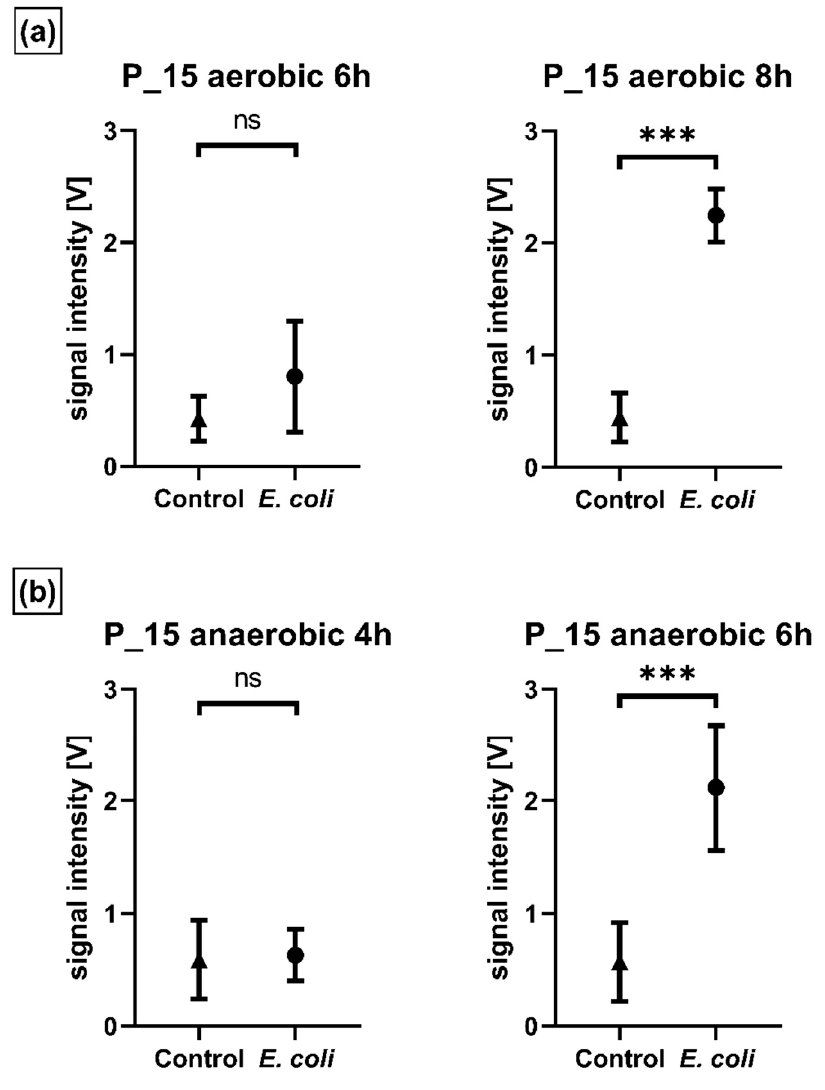
Figure 4. Unpaired t-Test E. coli ( n = 6) vs. Control ( n = 6) (Mean, 95% CI) for ( a ) aerobic media: P_15 aerobic 6 h (not significant, p = 0.10); P_15 aerobic 8 h (*** p < 0.001). ( b ) Anaerobic media: P_15 anaerobic 4 h (not significant, p = 0.81); P_15 anaerobic 6 h (*** p < 0.001). Differences in P_15 SI are significant the first time after 8 h in aerobic media and after 6 h in anaerobic